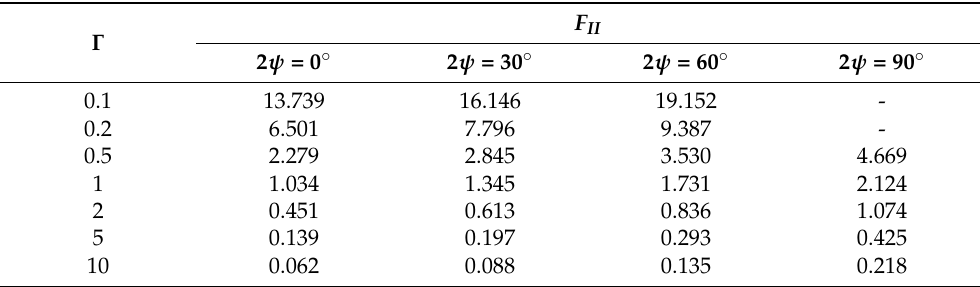
Table 6. Values of normalised stress intensity factors F II calculated for a rectangular plate with a central sharp corner under pure shear loading, a / w =